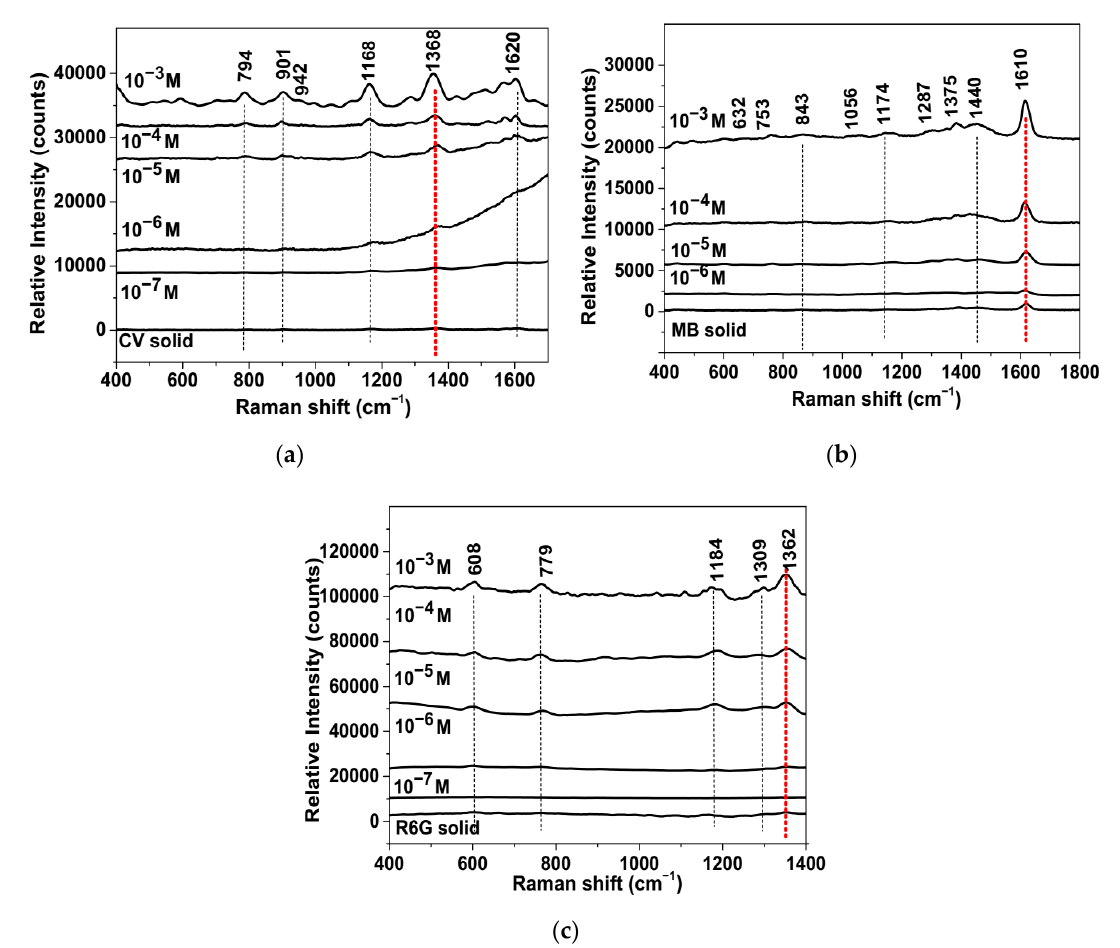
Figure 6. Raman spectra of ( a ) CV, ( b ) MB, and ( c ) R6G powders compared with SERS/SERRS spectra of the analytes with different concentrations decorated on a Cu/g-CN substrate. All spectra were plotted following baseline subtraction (see Figure S1). The red line indicates the characteristic peak used to determine the SERS activity (see text and Supporting Information). The spectra have been vertically displaced for clarity. The counts shown correspond to an integration time of 100 s of 50 accumulated scans, each with a 2-s exposure period. We note that for the CV sample prepared with a 10 − 7 M concentration, an additional fluorescence background contribution remained that was not fully accounted for by the baseline subtraction procedure. This was most likely due to some analyte molecules that were not completely removed from the underlying glass support by the washing procedure.